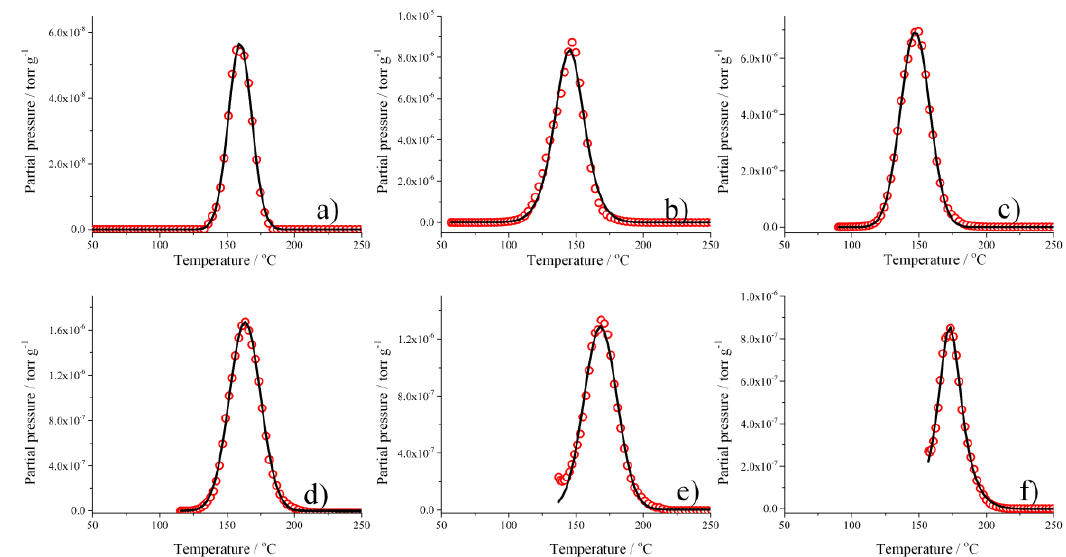
Figure 4. Thermal desorption of H 2 from Pd 79 –Ag 21 foil after absorption at: ( a ) 25 °C; ( b ) 60 °C; ( c ) 100 °C; ( d ) 120 °C; ( e ) 140 °C; and ( f ) 160 °C.